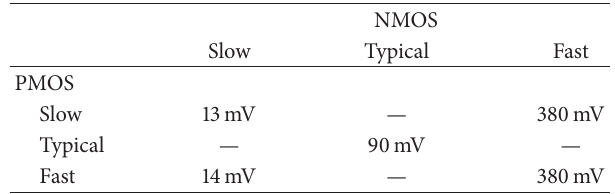
Figure 14: (a) Reference resistances. 𝑅 (b) The difference between reference resistances (the amount of margins separating the states). 01 shows the difference between 𝑅 − 𝑅 ( 𝑅 ). 10 shows “ 𝑅 refa refb